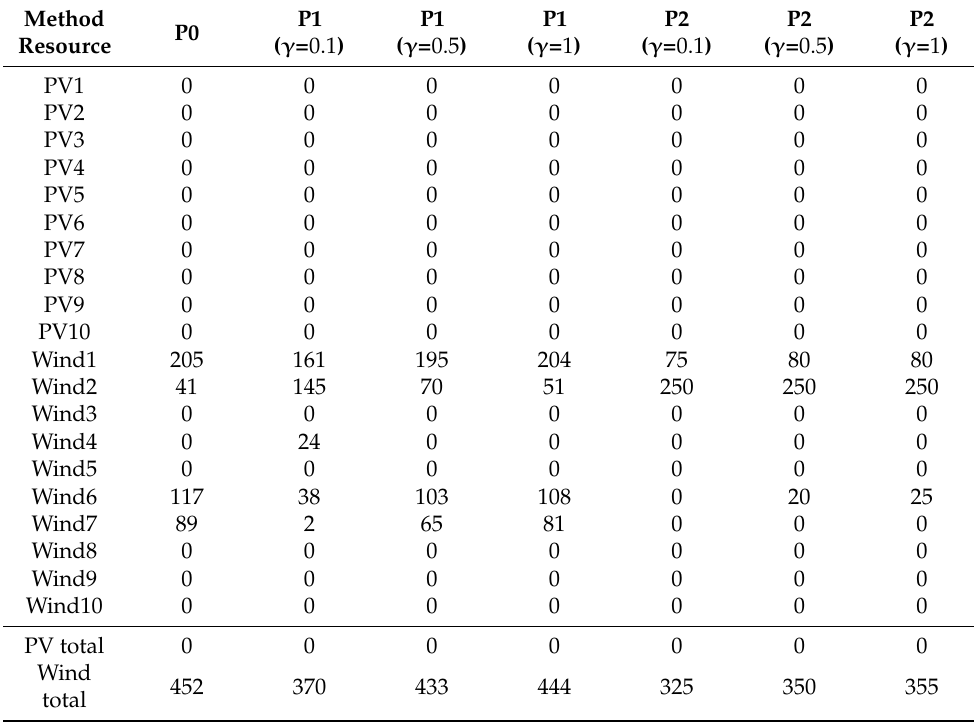
Table 2. VPP implementation results for a residential